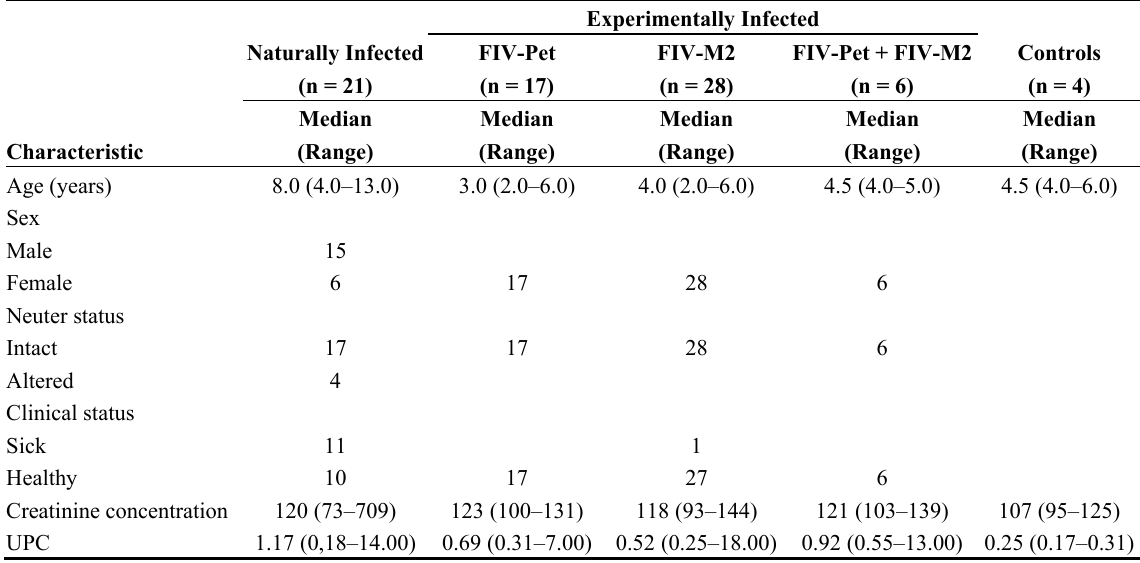
Table 1. Characteristics and creatinine and urine protein concentrations of study